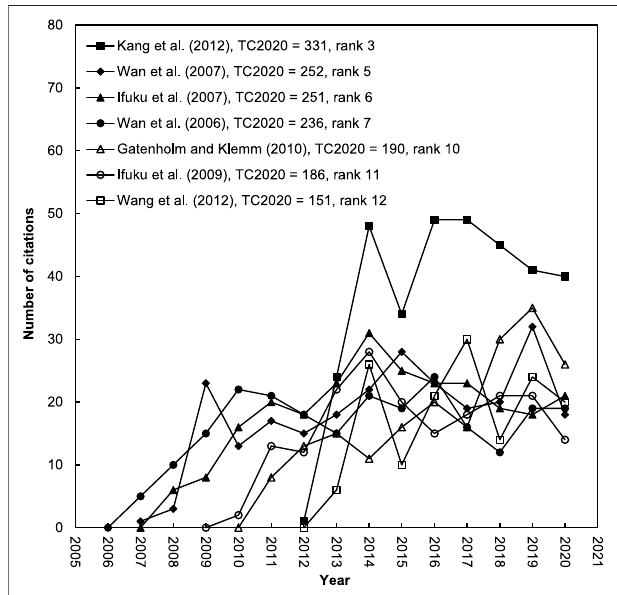
FIGURE 5 | The citation histories of the top seven most frequently cited articles with search keywords in their title or author keywords ( TC 2020 > 150).